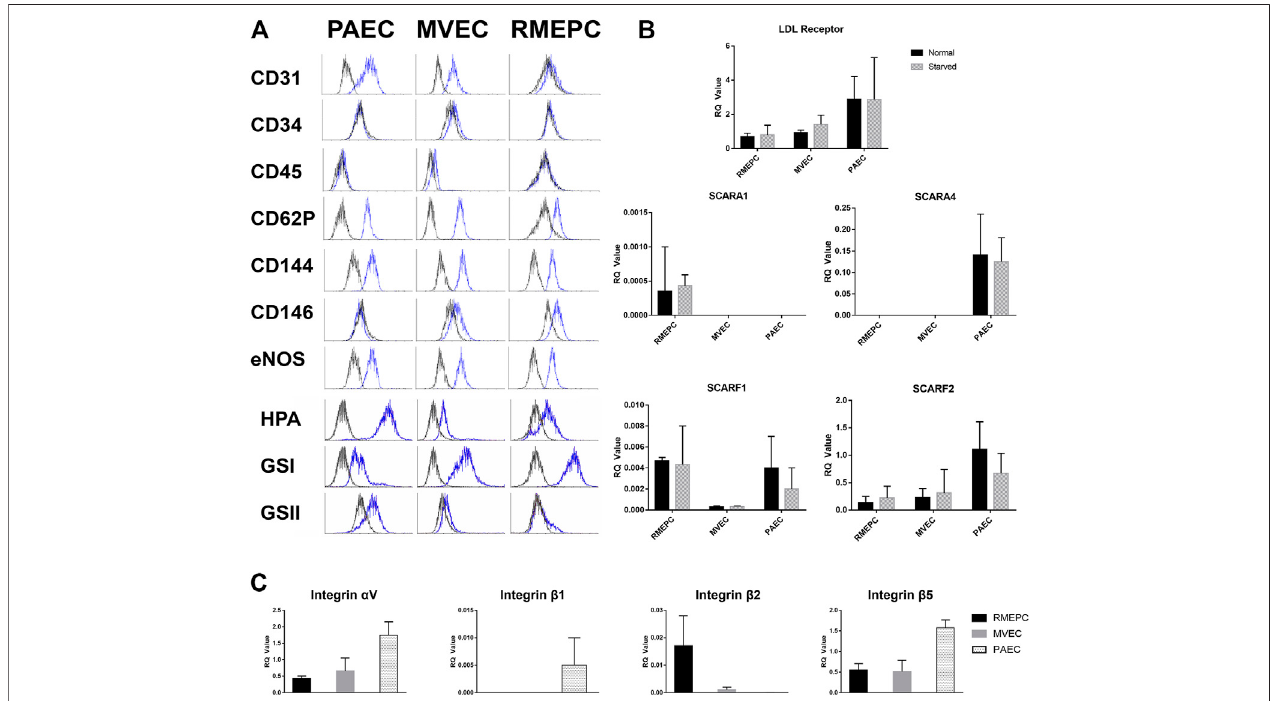
FIGURE 2 | PAEC, MVEC, and RMEPC express representative endothelial cell associated markers and lectin binding properties as assessed via fl ow cytometry (A) . In addition, gene expression of LDL-receptor, selected scavenger receptors, and selected integrin chains were assessed via qPCR (B,C) . For qPCR data, n (cid:2) 3 for each